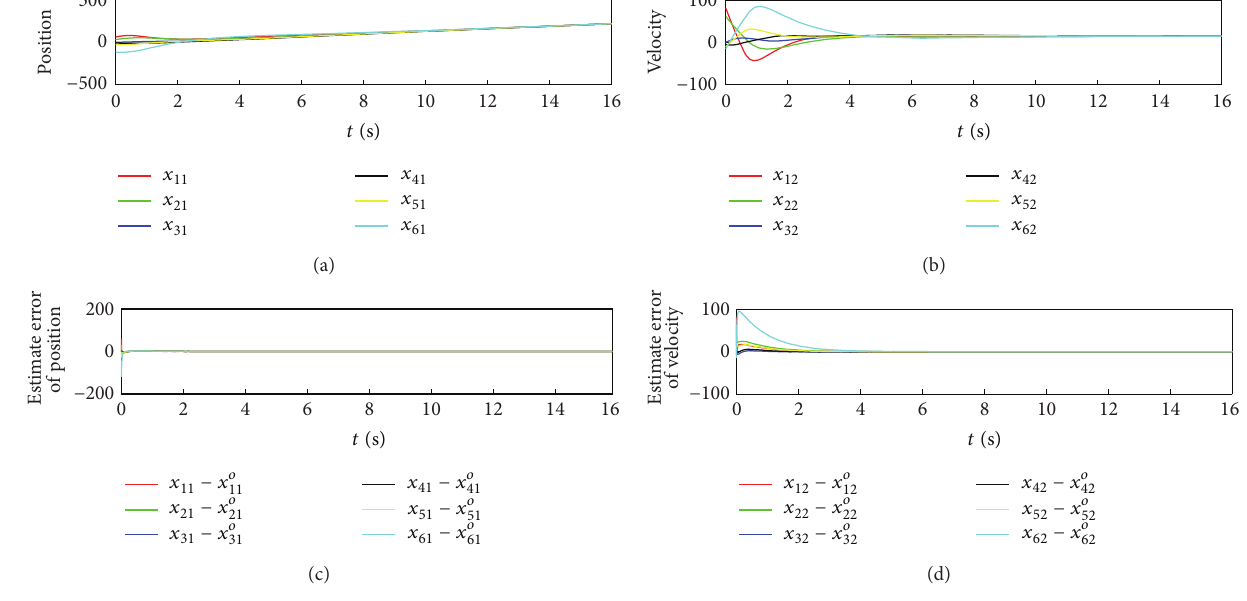
Figure 8: The evolutions of state and estimate error of each